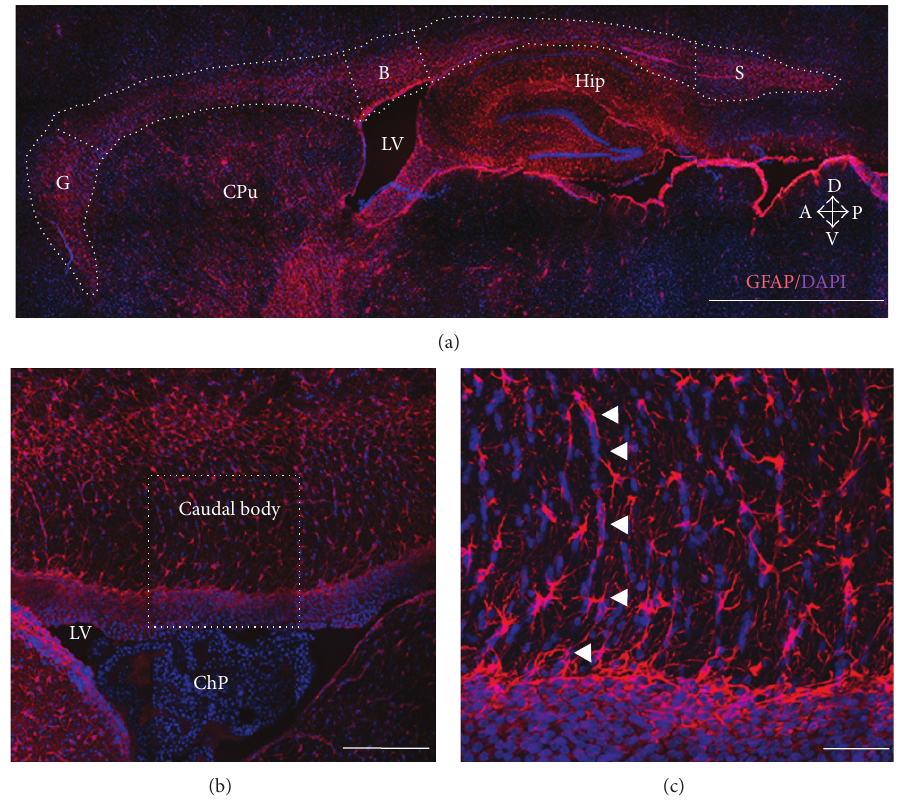
Figure 1: The rat corpus callosum (CC). (a) Sagittal sections from young female rat brains were immunostained for GFAP, and nuclei were labeled with DAPI. The CC was divided into three regions: genu (G), body (B), and splenium (S) to determine glial cell density. Other brain regions are indicated for anatomical reference: caudate-putamen (CPu), hippocampus (Hip), and lateral ventricle (LV). Arrows show anatomical orientation: dorsal (D), ventral (V), anterior (A), and posterior (P). (b) Higher magnification of the caudal body of the rat CC; notice that the lateral ventricle (LV) contains the choroid plexus (ChP) in close interaction with GFAP-positive cells from the CC. (c) Higher magnification of the square in (b) to highlight fibrous astrocytes from the body of the CC; notice that nuclei stained by DAPI show a radial orientation, and astrocytes align accordingly (arrowheads). Scale bars: 200 𝜇 m (a), 100 𝜇 m (b), and 50 𝜇